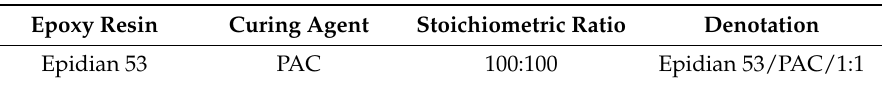
Table 2. Composition of the unmodified epoxy adhesive.